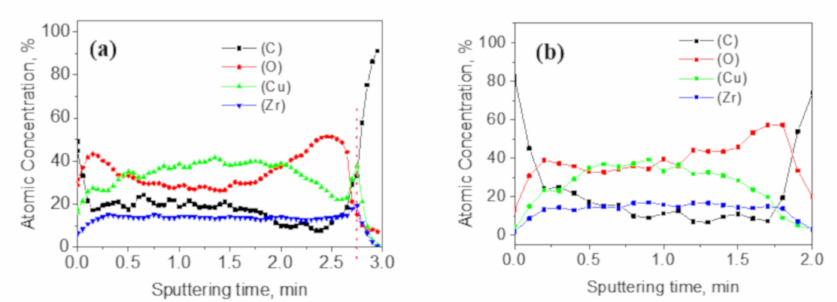
Figure 10. Auger Electron Spectroscopy (AES) diagrams of a 50 nm Cu-7.3%Zr alloy film: ( a ) as deposited, ( b ) annealed films.